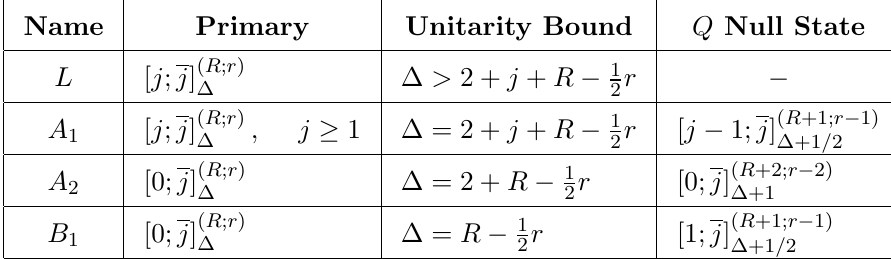
Table 13 . Q shortening conditions in four-dimensional N = 2